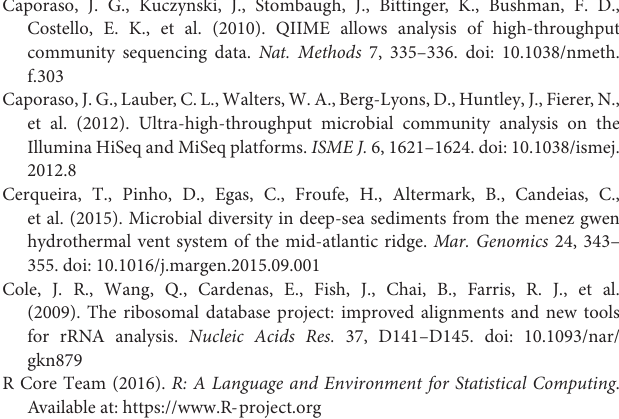
TABLE S1 | Sequence statistics during processing in DADA2. TABLE S2 | ASVs significantly correlated with nitrate or pore fluid manganese concentrations. TABLE S3 | Proportion of samples assigned at the order level in samples. TABLE S4 | Taxonomic assignments and abundances of top 100 most abundant ASVs, which were presenting in Supplementary Figure S5 . TABLE S5 | Alpha diversity measures for each